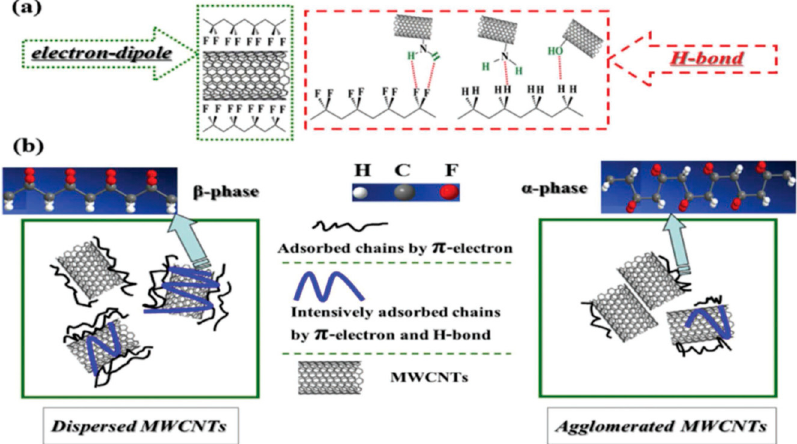
Figure 4. Schematic showing the effect of MWCNTs on the β -phase formation in PVDF: ( a ) Hydrogen bonding between functionalized MWCNTs and PVDF chains; ( b ) the adsorbed chains of PVDF on the surface of MWCNTs influenced by the dispersion of MWCNTs. Reproduced with permission from [96], published by Elsevier, 2014.